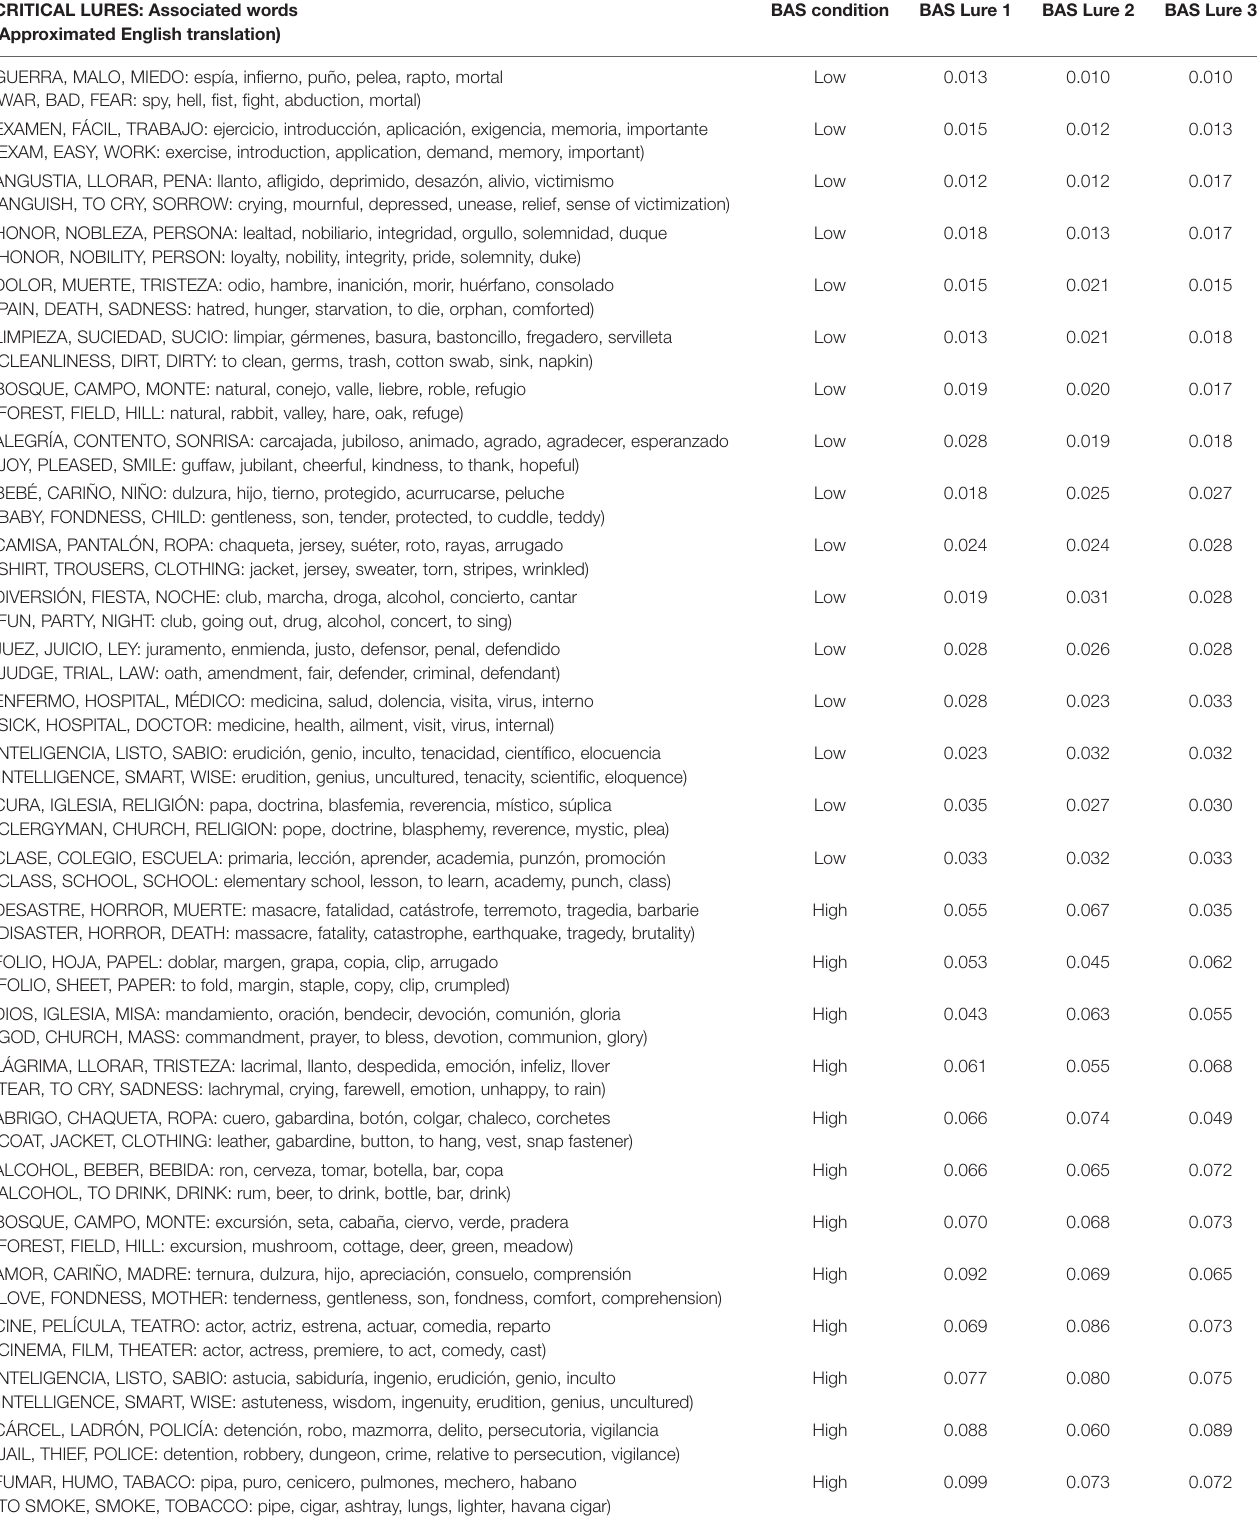
TABLE 1 | Thirty-Two Six-Word Lists with Three Critical Lures (Approximated English Translation), Backward Associative Strength (BAS) Condition, and Critical Lure BAS. CRITICAL LURES: Associated words (Approximated English